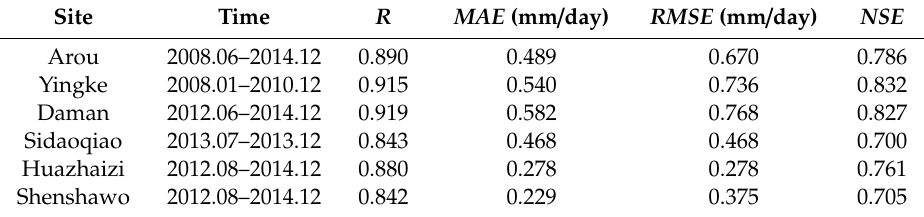
Figure 3. Annual ET in the upstream reaches of the Heihe River Basin. Table 3. Validation results of daily evapotranspiration estimated by the proposed algorithms at six eddy covariance (EC)